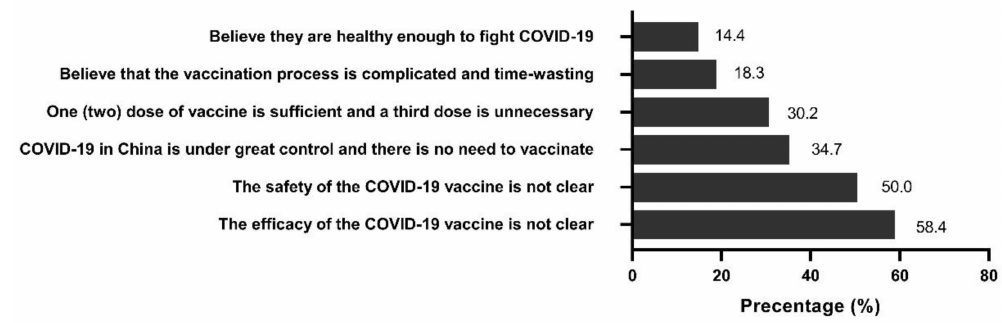
Figure 2. Reasons for responding “No” or “Not sure” regarding willingness to accept a third dose of COVID-19 vaccine (n =